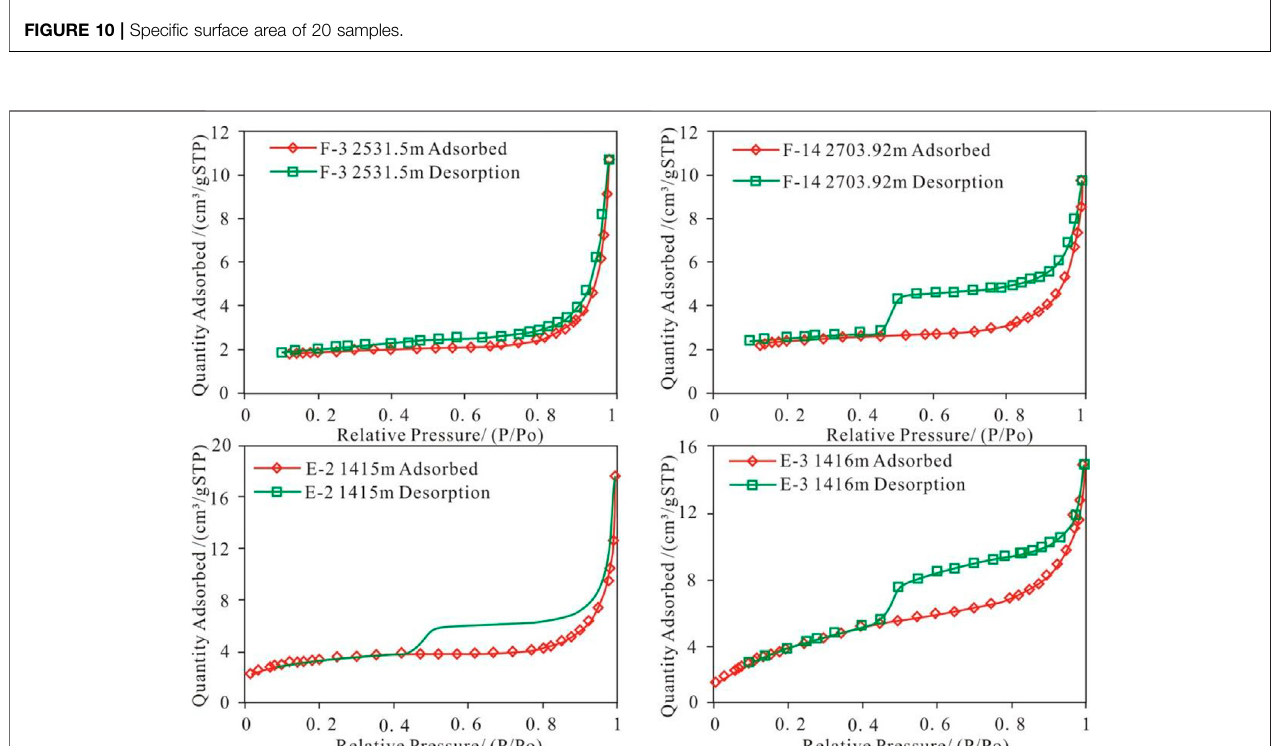
FIGURE 11 | Comparison of the isotherms and hysteresis of Shanxi